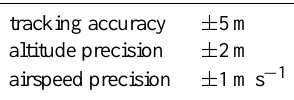
Table 2. Typical ROCS autopilot